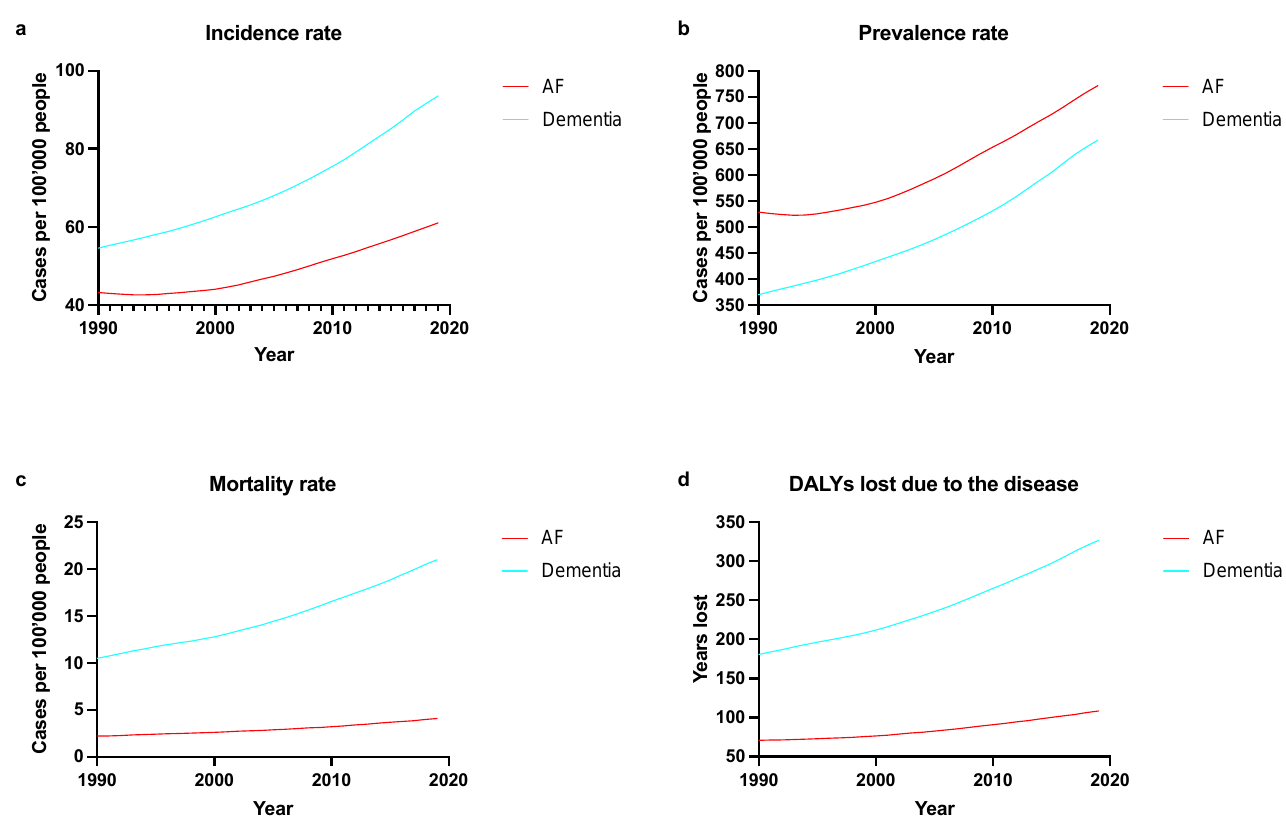
Figure 3. Global historical trends (1990–2019) for the crude estimates of the evaluated epidemiological metrics: panel ( a ), incidence rate; panel ( b ), prevalence rate; panel ( c ), mortality rate; panel ( d ), DALYs lost due to the disease.